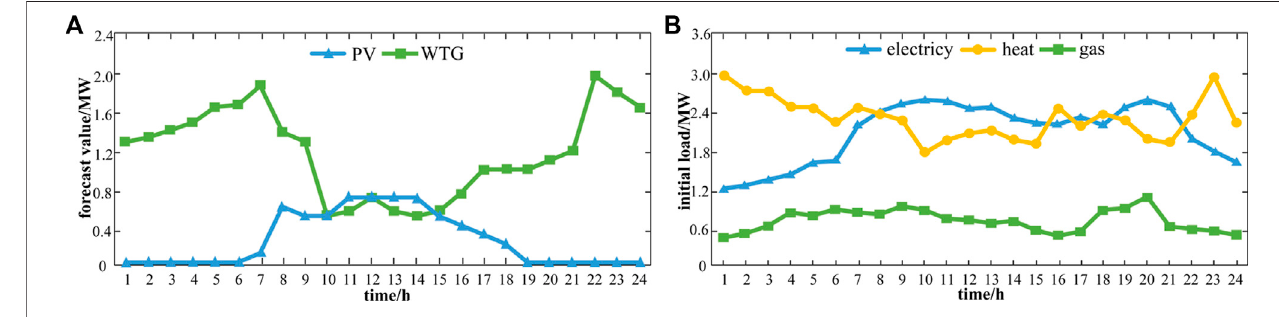
FIGURE 6 | Renewable energy and load data.